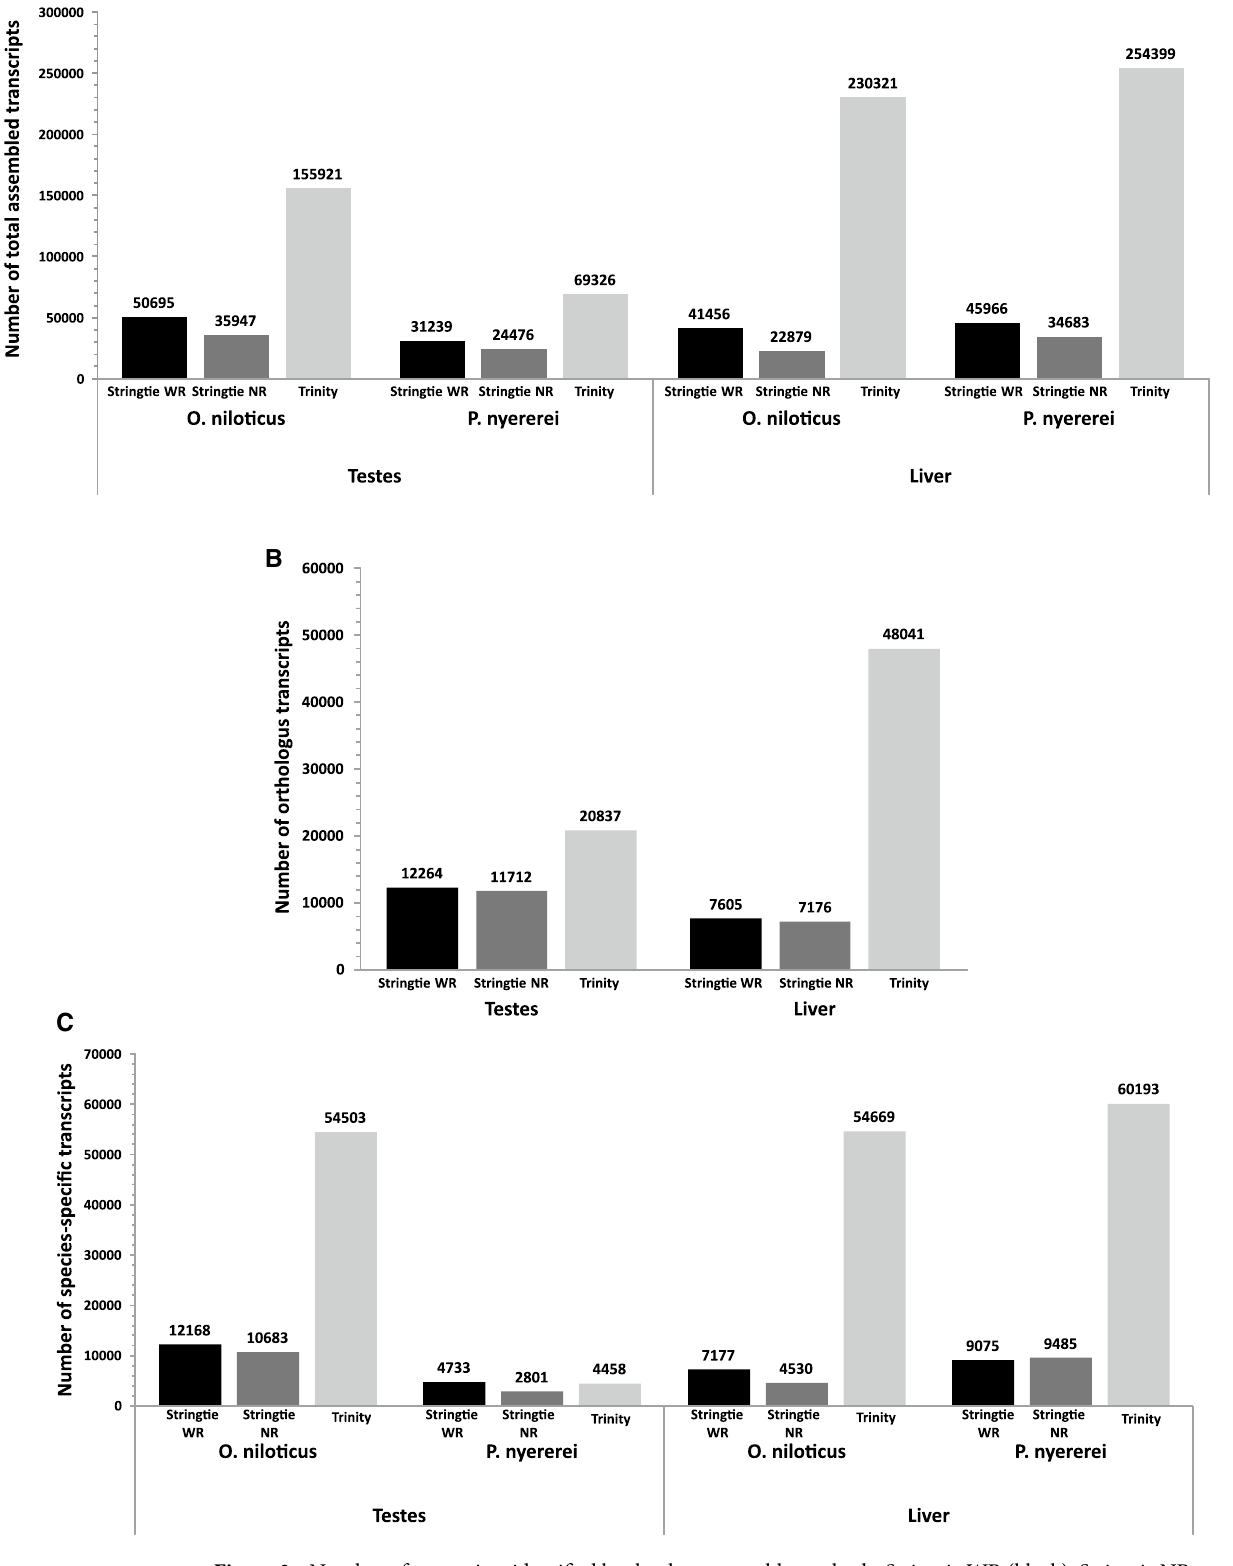
Figure 2. Number of transcripts identified by the three assembly methods. Stringtie WR (black), Stringtie NR (dark gray), Trinity (light gray). ( A ) Total number of assembled transcripts found in each tissue of each fish for the three transcriptome assembly methods. ( B ) Total number of orthologus transcripts between the two fishes in both the tissues. ( C ) Number of transcripts expressed uniquely to a fish in each